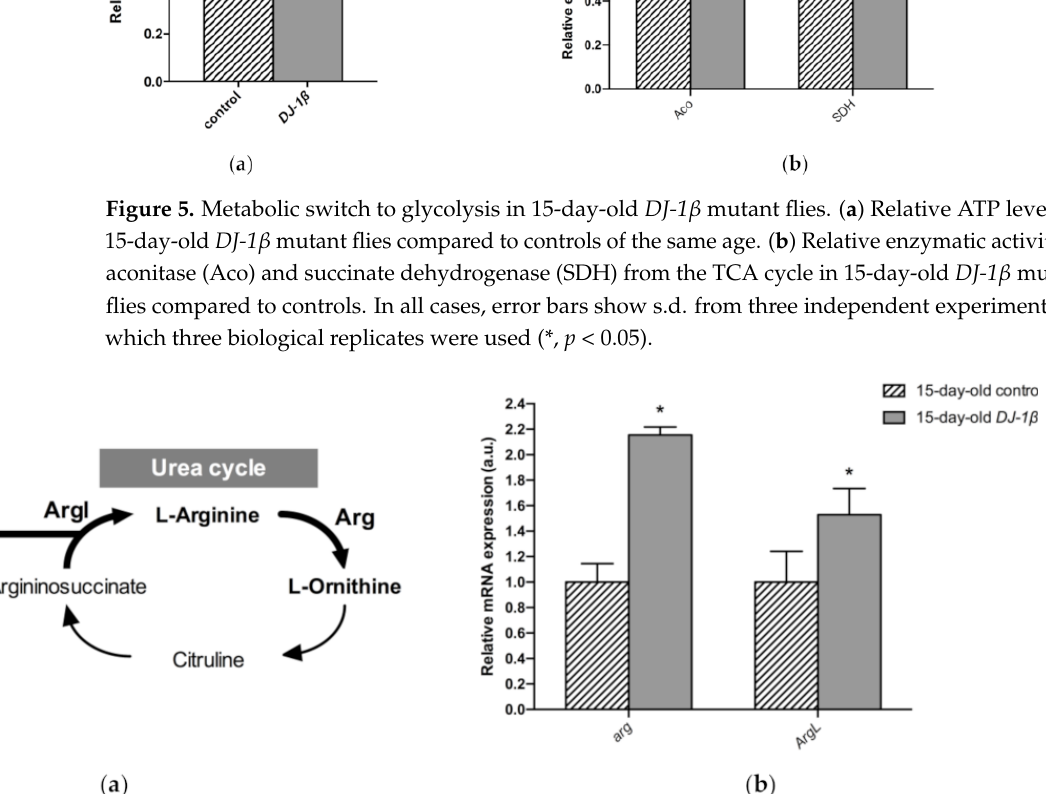
Figure 6. Alterations in the urea cycle in 15-day-old DJ-1 β mutant flies. ( a ) Schematic diagram of the urea cycle. Fumarate is a final metabolite that can enter the TCA cycle. ( b ) Expression levels of selected enzymes of the urea cycle, arginase ( Arg) and argininosuccinate lyase ( ArgL ). Error bars show s.d. from four independent experiments (*, p <